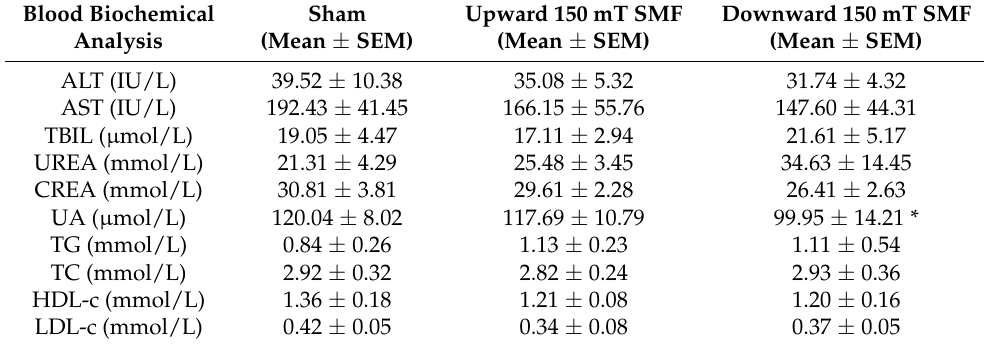
Table 2. Blood biochemical detection of mice exposed long-term to sham, upward and downward 150 mT SMFs. We conducted statistical analysis for all data; comparisons were made between each sham and 150 mT SMF group. Red marks illustrate that data was statistically more significant than sham. All groups contained six mice, and values show mean ± SEM, and “*” means p < 0.05. In consideration of the readability of the paper, no statistical significance ( p > 0.05) was not labeled uniformly.